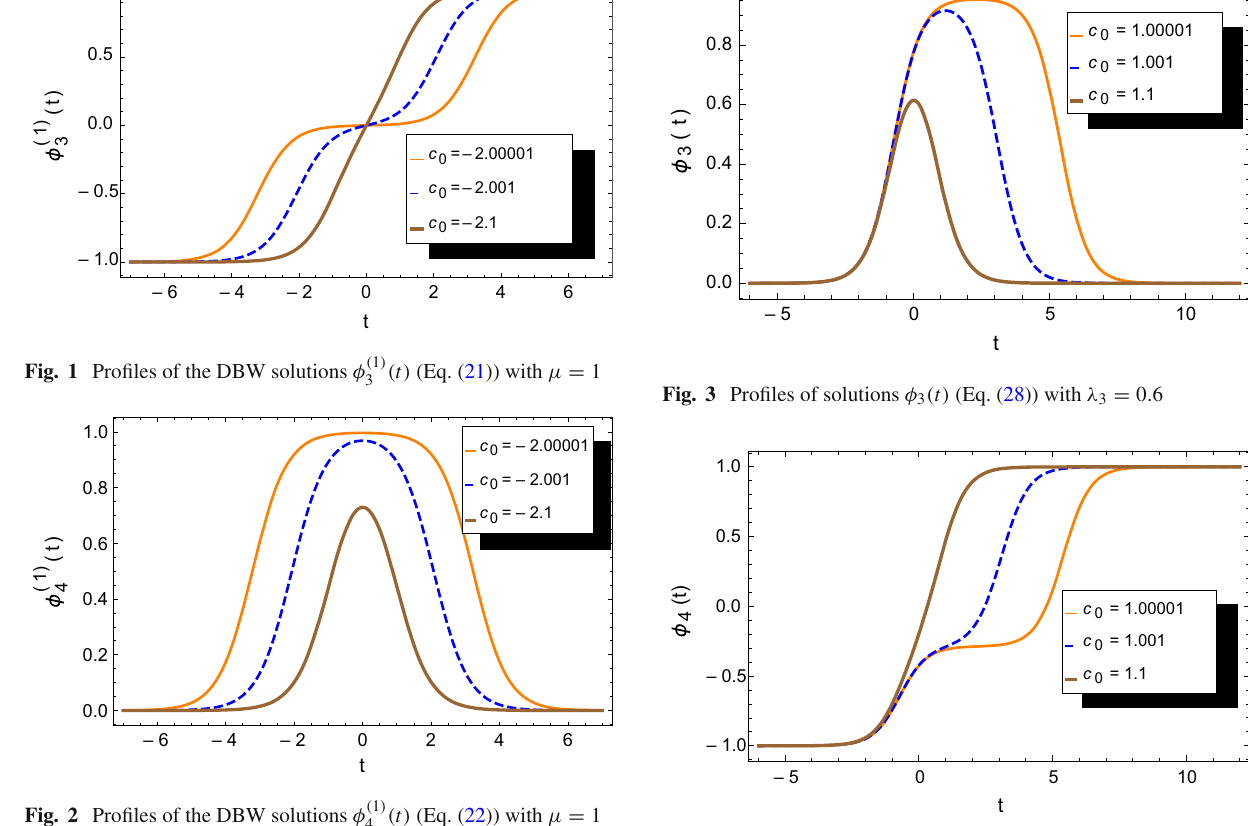
Fig. 2 Profiles of the DBW solutions φ ( 1 )